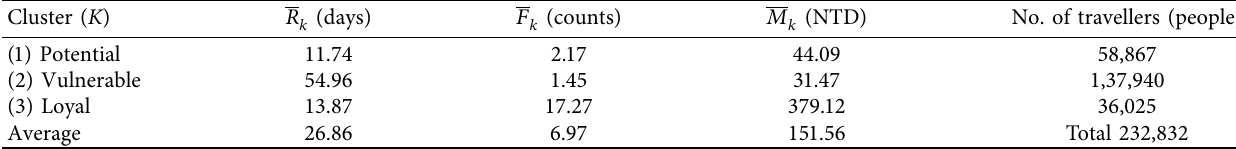
Table 12: Clustering results by K -means for 2018 Q 4.